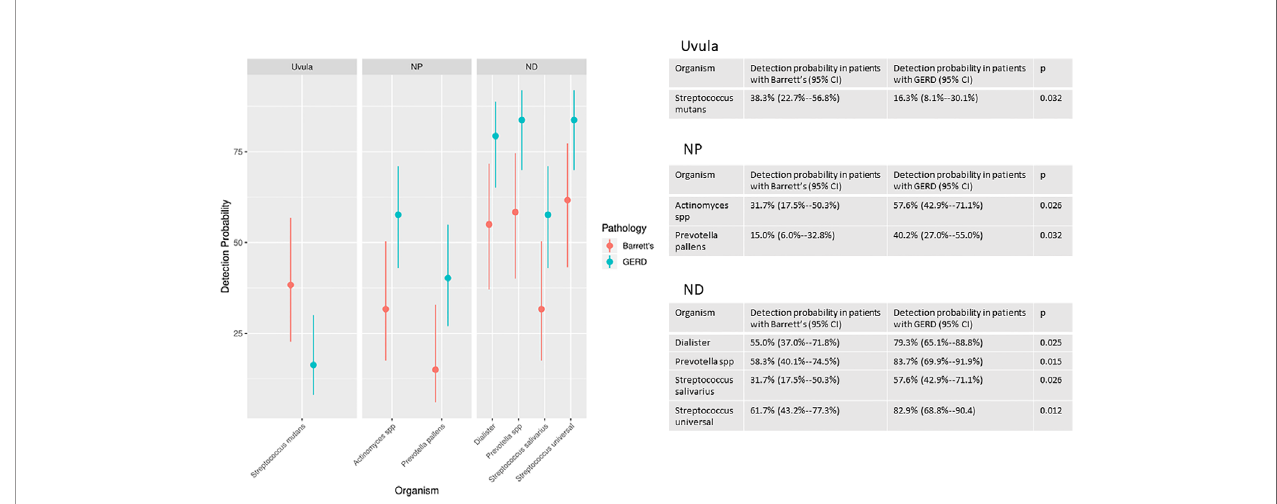
FIGURE 2 | Organisms with signi fi cantly different detection rates at the uvula, proximal esophagus (NP) and distal esophagus (ND) in the Barrett ’ s group compared to the GERD without Barrett ’ s